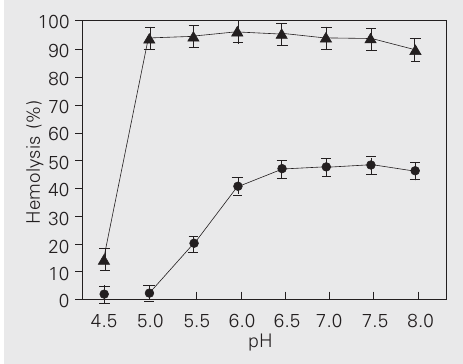
Figure 2. Effect of bacterial growth and H-NS on hemolysin synthesis. Erythrocyte lysis by Escherichia coli MC4100 (circles) and MC41 (triangles) was measured by absorbance at 405 nm. Each point indicates the mean ± SEM for four independent experiments. Hemoly- sin expression in E. coli MC41 was not growth phase dependent, compared to the wild- type strain MC4100. P < 0.001 (chi-square significance